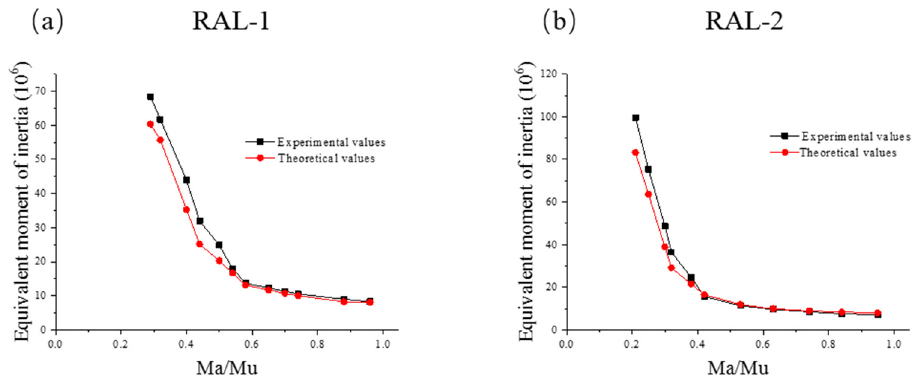
Figure 10. Comparison between experimental and theoretical values of equivalent moment of inertia of beam. ( a ) RAL-1, ( b ) RAL-2 .